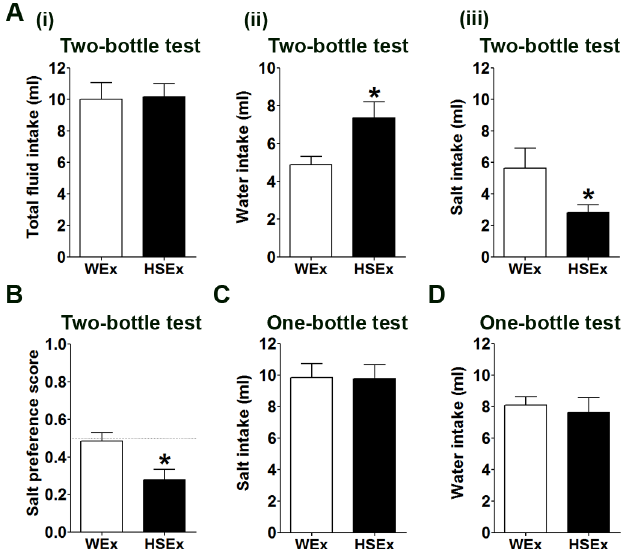
Figure 4. The effect of AngII on IS and water intake. Ai, total fluid intakes in WEx and HSEx rats in 1 h two-bottle choice tests with water and IS after AngII administration. Water intake (Aii) and IS intake (Aiii) in WEx and HSEx rats after AngII administration. B, salt preference score in WEx and HSEx rats after AngII administration. One-bottle tests with IS (C) and water (D) following AngII administration. Values are means + SEM of n=10 animals per group. *p , 0.05. HSEx, hypertonic saline exposed; IS, isotonic saline; WEx, water exposed.